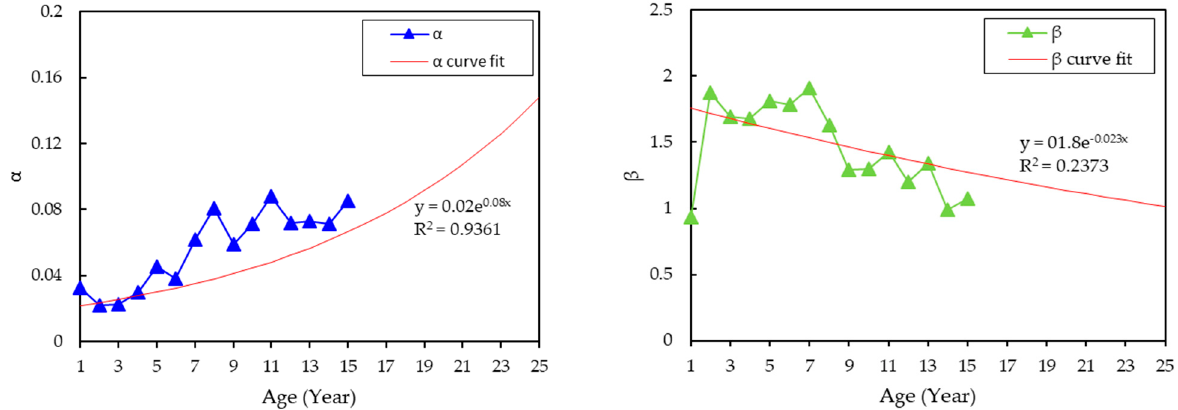
Figure 5. Parameters estimation for acidity based on Weibull distribution model.